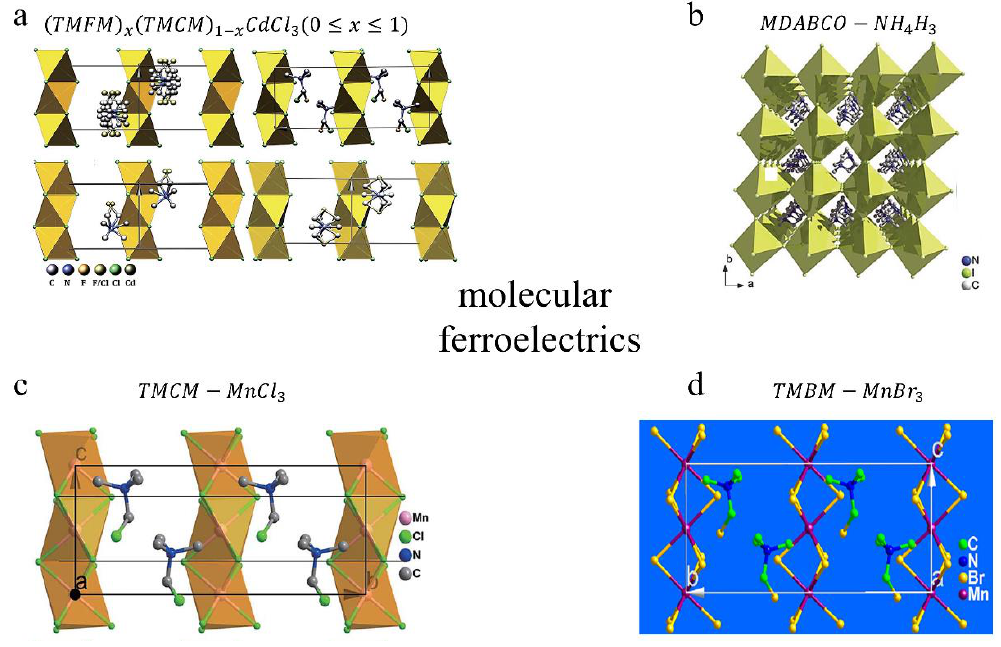
Figure 5. Material innovation: molecular ferroelectrics. ( a ) crystal structure of ( TMFM ) ( TMCM ) CdCl 3 (0 ≤ x ≤ 1). Copyright from The American Association for the Advancement of Science. ( b ) crystal structure of MDABCO–NH 4 H 3 . Copyright from The American Association for the Advancement of Science. ( c ) the crystal structure of TMCM − MnCl 3 . Copyright from The American Association for the Advancement of Science. ( d ) crystal structure of TMBM − MnBr 3 . Copyright from ACS.